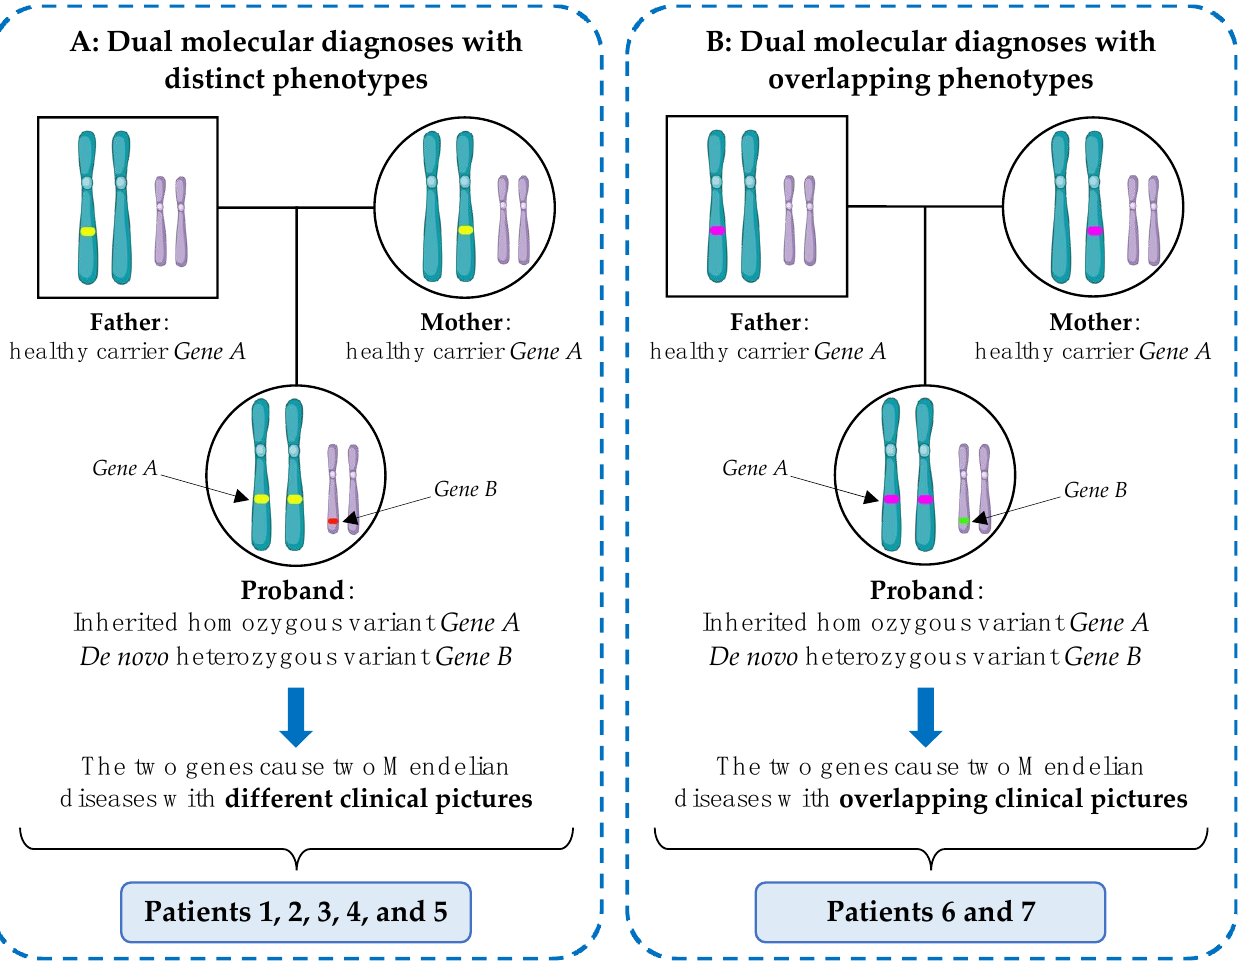
Figure 1. Dual molecular diagnoses patterns. ( A ). Dual molecular diagnoses with distinct pheno- types: patients present a blended phenotype due to the simultaneous presence of two Mendelian disorders caused by variants at two independently segregating loci. Each condition is characterised by a different and specific set of signs and symptoms, and they may be recognised as discrete upon reverse phenotyping. ( B ). Dual molecular diagnoses with overlapping phenotypes: patients’ clinical picture may be ascribed to either of the two underlying Mendelian disorders. In the exemplified cases, one condition is inherited from both patients in an autosomal recessive manner, and the other has a de novo origin in the proband; nevertheless, all inheritance patterns are possible.